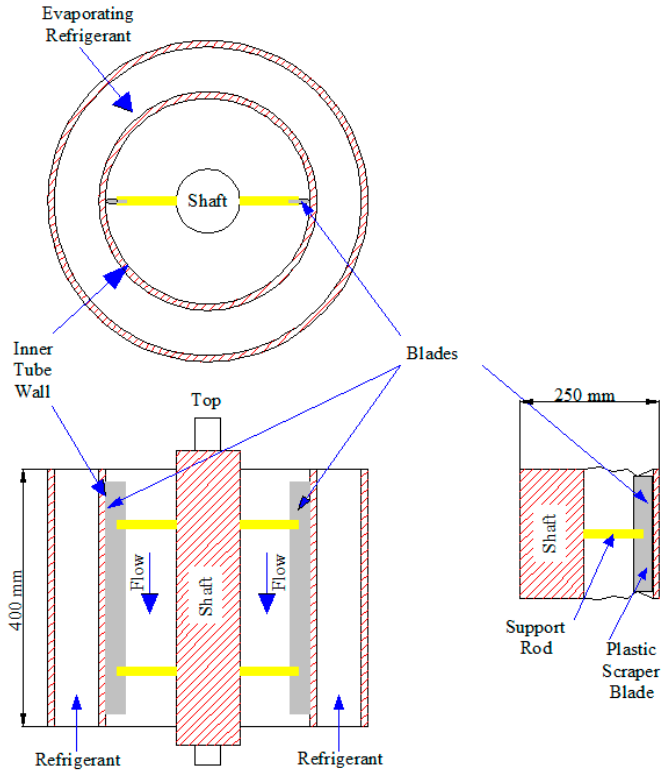
Figure 2. Schematic of a scraped surface ice slurry generator. Table 1. The detail description of scraping system.